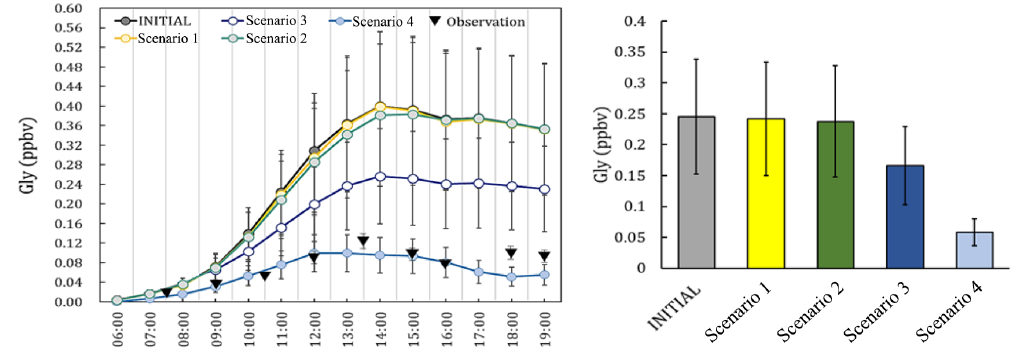
Figure 2. The observation data (measured at local time), the concentrations and the daily average concentration of Gly predicted from the different